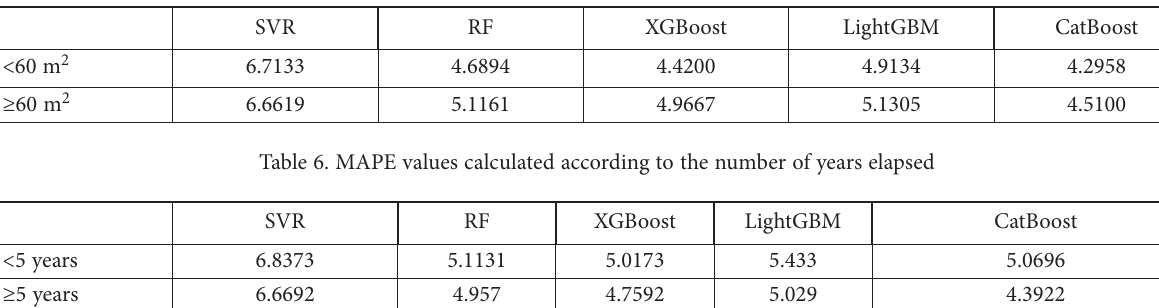
Table 5. Mean absolute percentage error (MAPE) values calculated according to property size